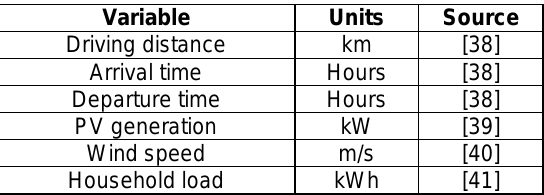
Table B.2. Variables initialized or updates using